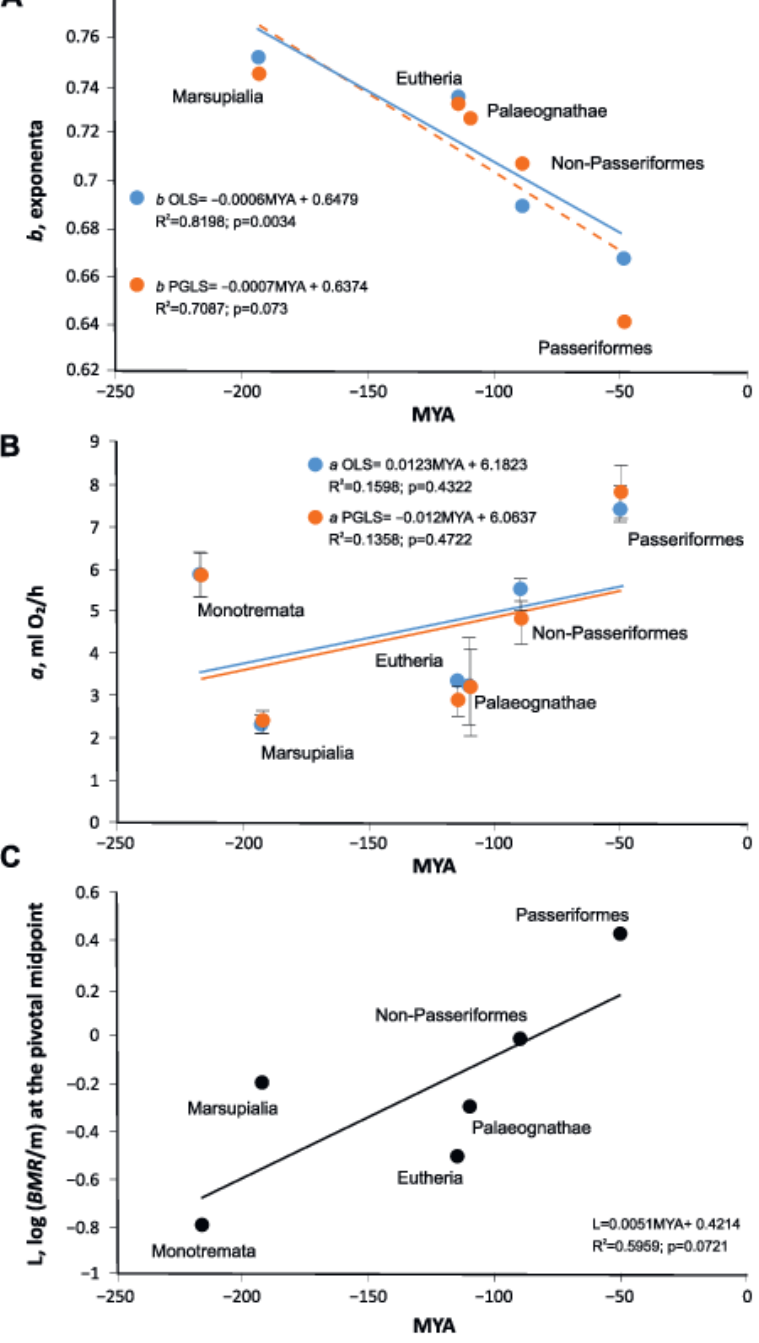
Figure 4. ( A ) Scaling exponents in five groups of endothermic animals’ dependence on the geologic time of divergence of the clades obtained by the phylogenetic generalized least squares (PGLS) and ordinary least squares (OLS). ( B ) The allometric coefficient in six groups of endothermic animals’ dependence on the geologic time of divergence of the clades by the phylogenetic generalized least squares (PGLS) and ordinary least squares (OLS). ( C ) The measure of scaling elevation, L, in six groups of endothermic animals’ dependence on the geologic time of divergence of the clades by ordinary least squares (OLS). MYA—million years ago.